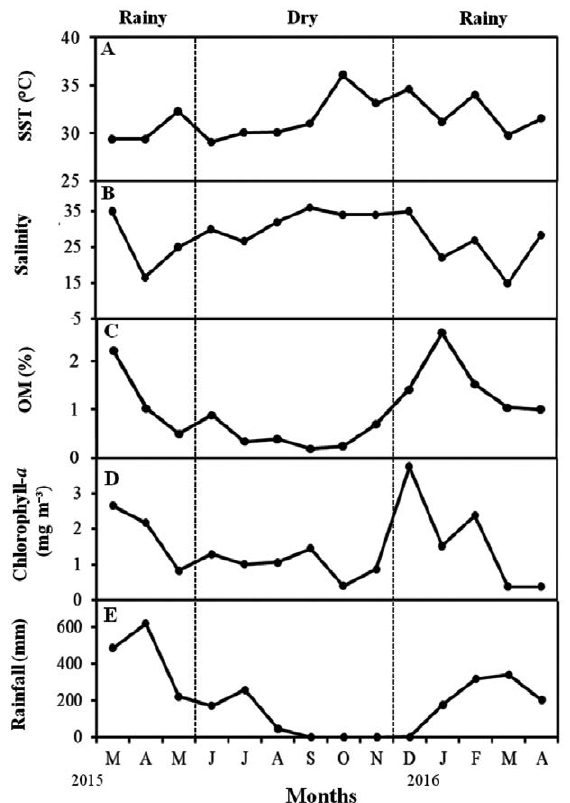
Fig. 2. – Variation in environmental variables at the tropical beach. A, sea surface temperature, SST (°C); B, salinity; C, organic matter, OM (%); D, chlorophyll a (mg m – ³); and E, rainfall (mm) during the study